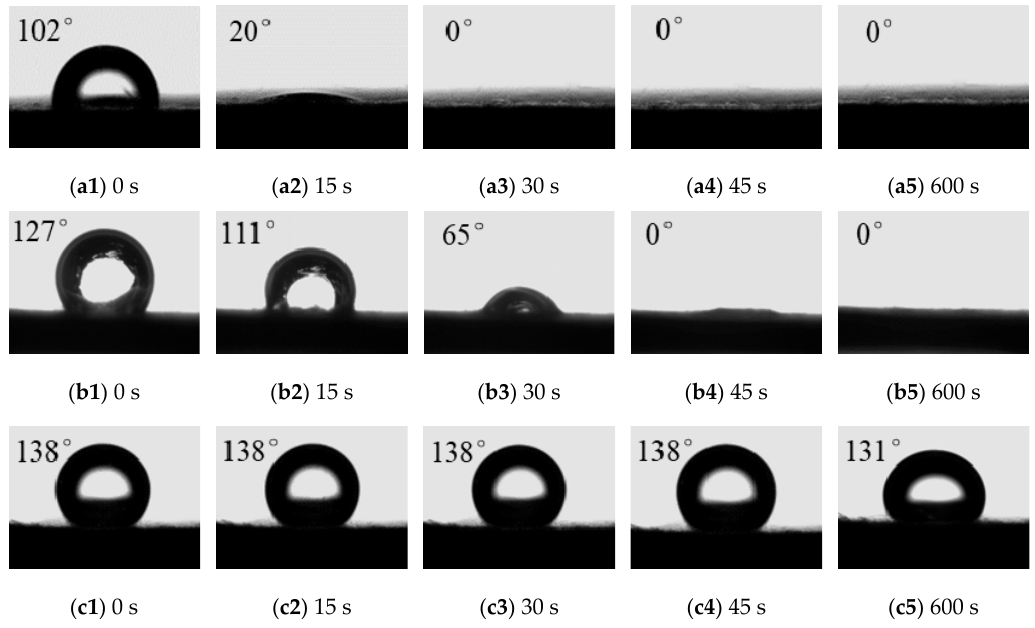
Figure 4. The water contact angle on samples made by glass microfibers: ( a ) IFT = 21 mN/m; ( b ) IFT = 17 mN/m; ( c ) IFT = 13 mN/m